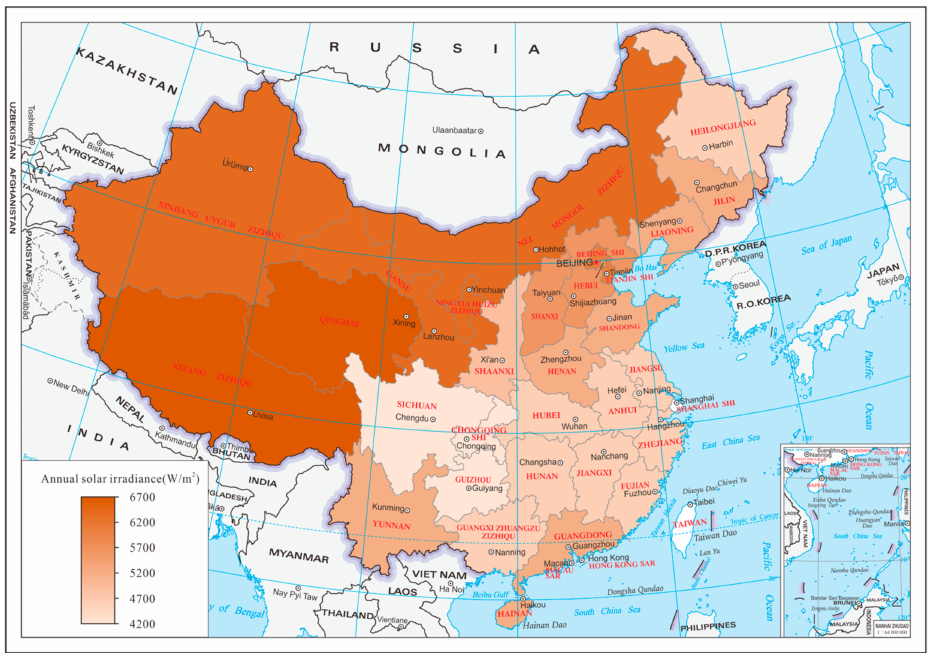
Figure 3. Distribution of solar radiation resources in various